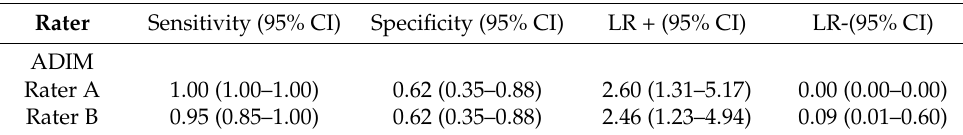
Proposed model for the dichotomous transformation of USI measurements: ROC value (95% CI) = 0.89 (0.74–1.00); p < 0.001 Youden Index = 0.78 M-TrA-PAR Cut-off point =